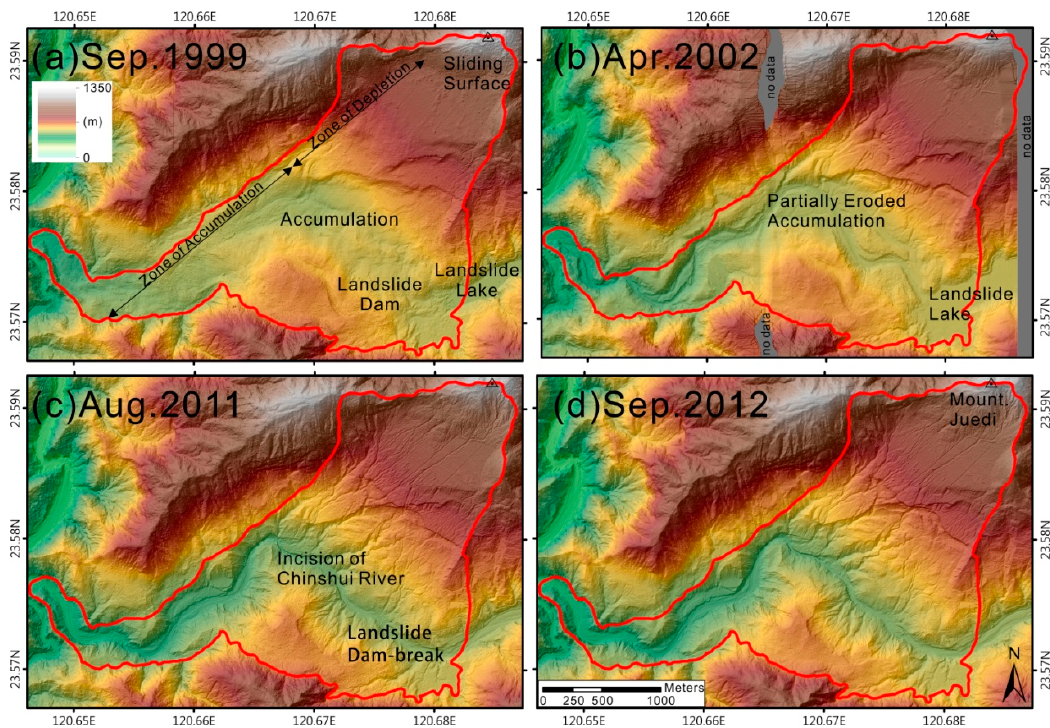
Figure 6. DEM data produced by three periods of ALS and one period of aerial photogrammetry: ( a ) the DEM produced by aerial photogrammetry in September 1999 immediately after the earthquake; and ( b – d ) the DEM data produced by ALS in April 2002, August 2011, and September 2011, respectively. These figures use an elevation shading shadow map to show the elevation distribution and the geomorphological features in which the grey parts represent the areas with no data.